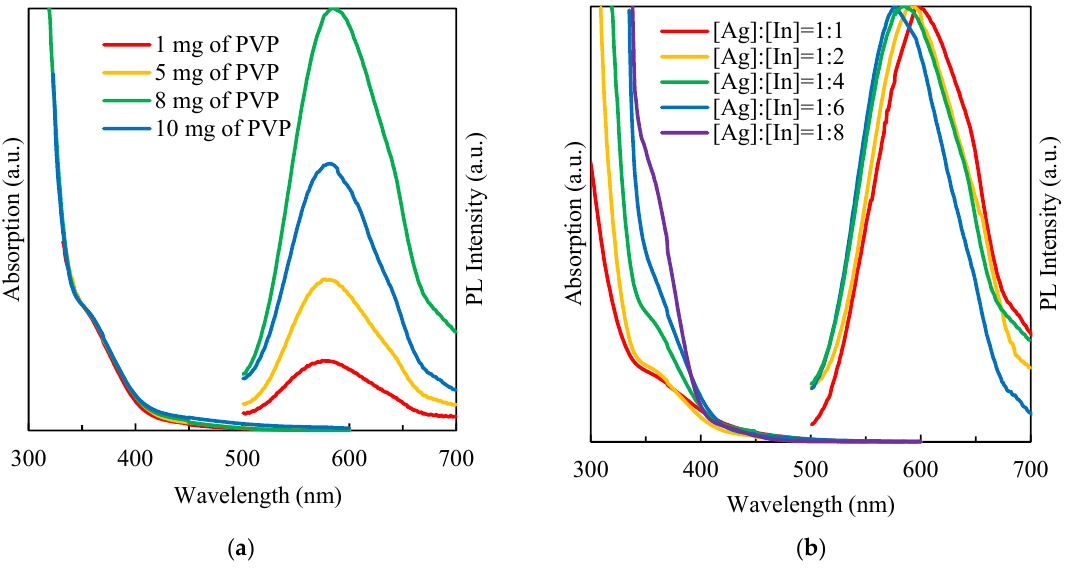
Figure 4. Absorption and PL spectra of AgInS 2 QDs solutions prepared with different ( a ) PVP concentrations, ( b ) molar ratio of [Ag]:[In].